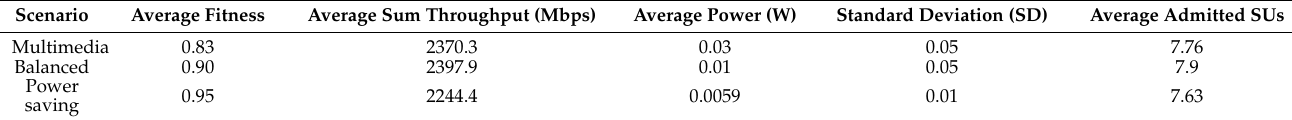
Table 9. Summary of the performance of TPPSO with DGP-BPSO under various